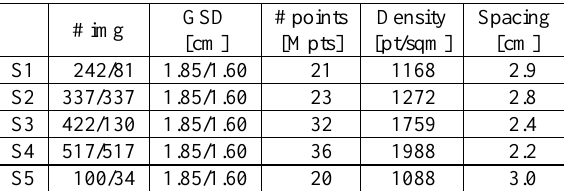
Table 4. Summary of the five scenarios